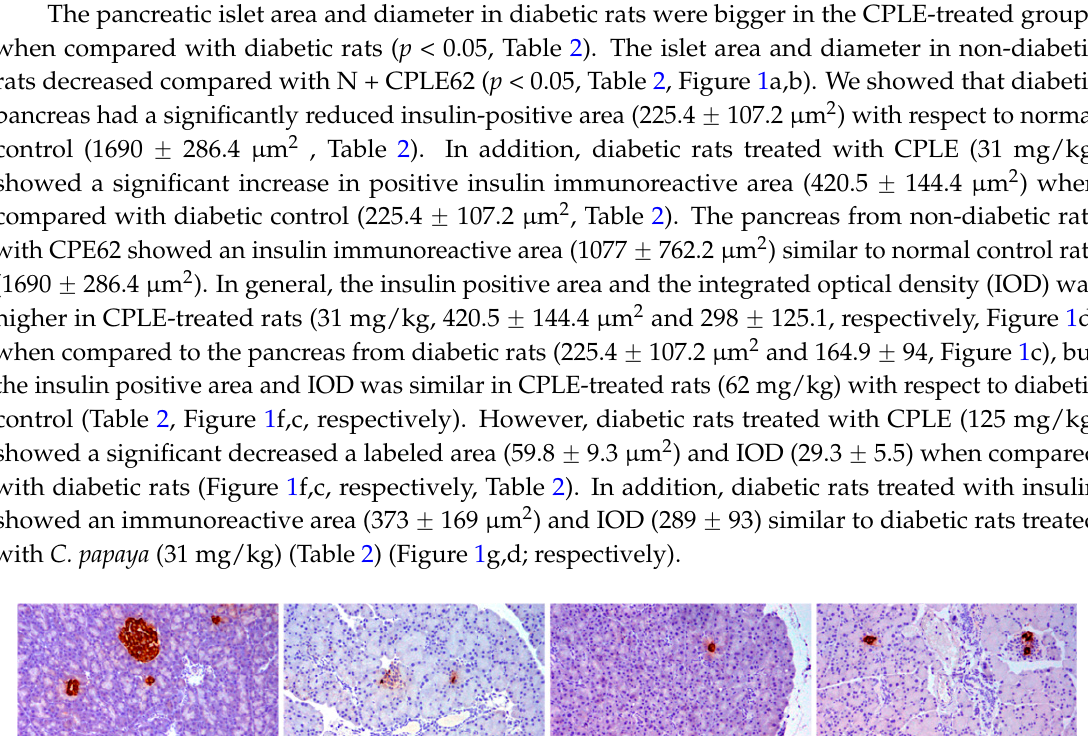
Table 2. Effect of the chloroform extract of C. papaya on the Pancreas islet.